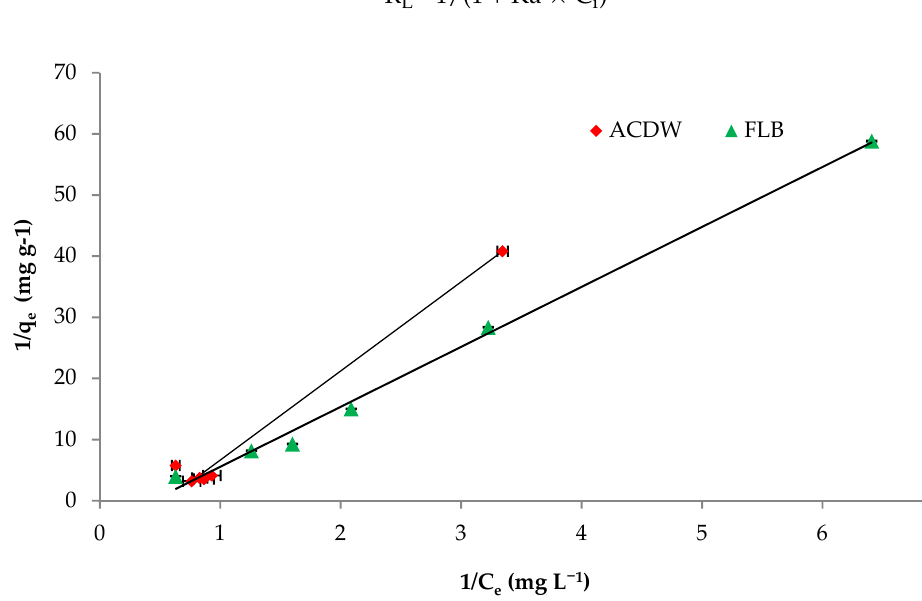
Figure 8. Langmuir isotherm plot for removal efficiency of IV2R dye. Freundlich isotherm gave a better fit for IV2R with a higher correlation coefficient of Table 3. Values of isotherm constants for IV2R dye removal by ACDB and 0.988 for LFB adsorbent, while this model gave a lower fit by ACDB adsorbent with cor- relation coefficient 0.856 as shown in Figure 9 and Table 3. On the other hand, the Freundlich constant “K f ” displays the sorption capacity on heterogeneous sites with adsorption capacity of the dye cation from the adsorbent. The value of the “n” parameter shows the intensity among dyes and biomass. The “K f ” values were 5.76 and 6.3 for both